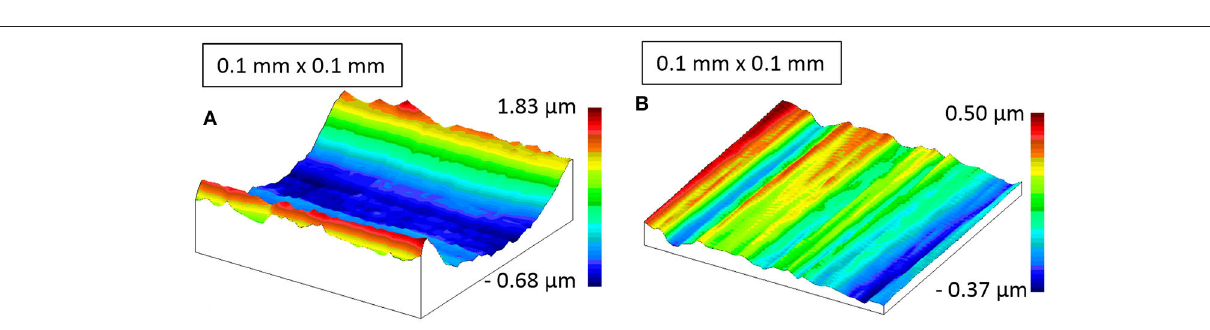
FIGURE 5 | (A) Machining trace of a turned surface (Sdq = 0.081; Sdr = 0.253%); (B) Machining trace of a milled surface (Sdq = 0.064; Sdr =